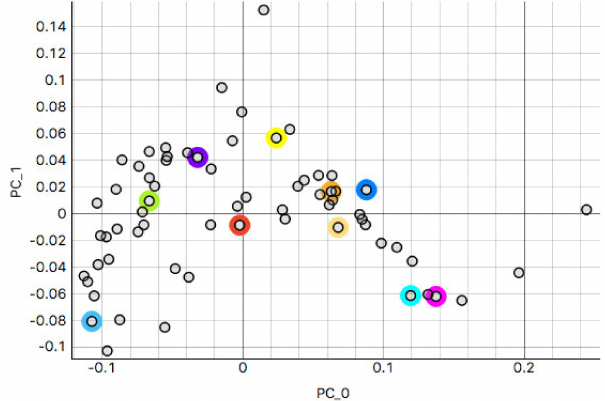
Figure A2. Scatterplot of colon examples along the first two principal components; the highlighted colors show the same random laboratories as in Figure 4, and names are not shown directly due to visual occlusion.